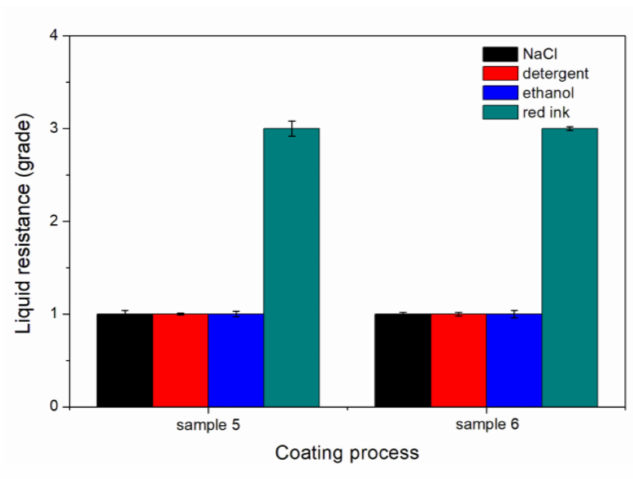
Figure 10. The liquid resistance of waterborne coating on Chinese fir (samples 5–6 from Table 2).